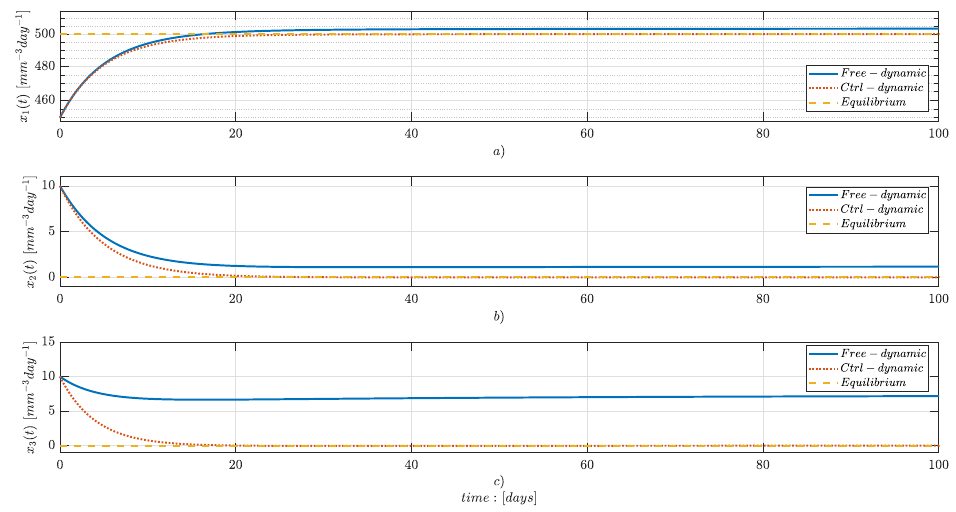
Figure 3. Convergence of the cell populations of resting macrophages, activated macrophages, and